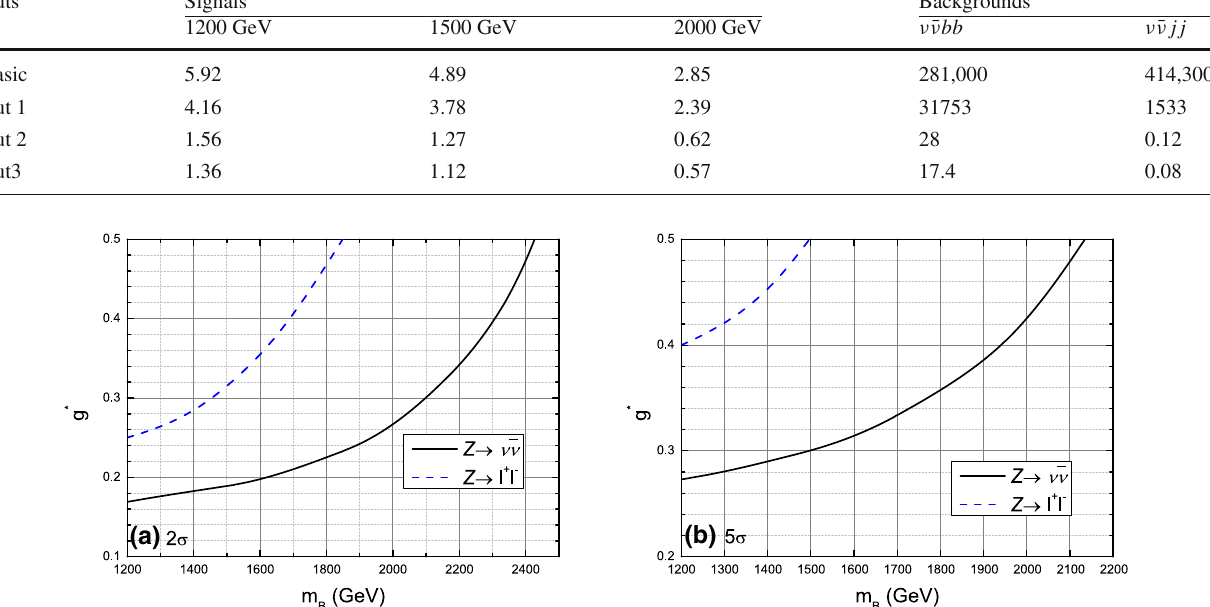
Fig. 5 2 σ exclusion limit (left) and 5 σ discovery prospects (right) contour plots for the signal in g ∗ − m B planes at 3 TeV CLIC with integral